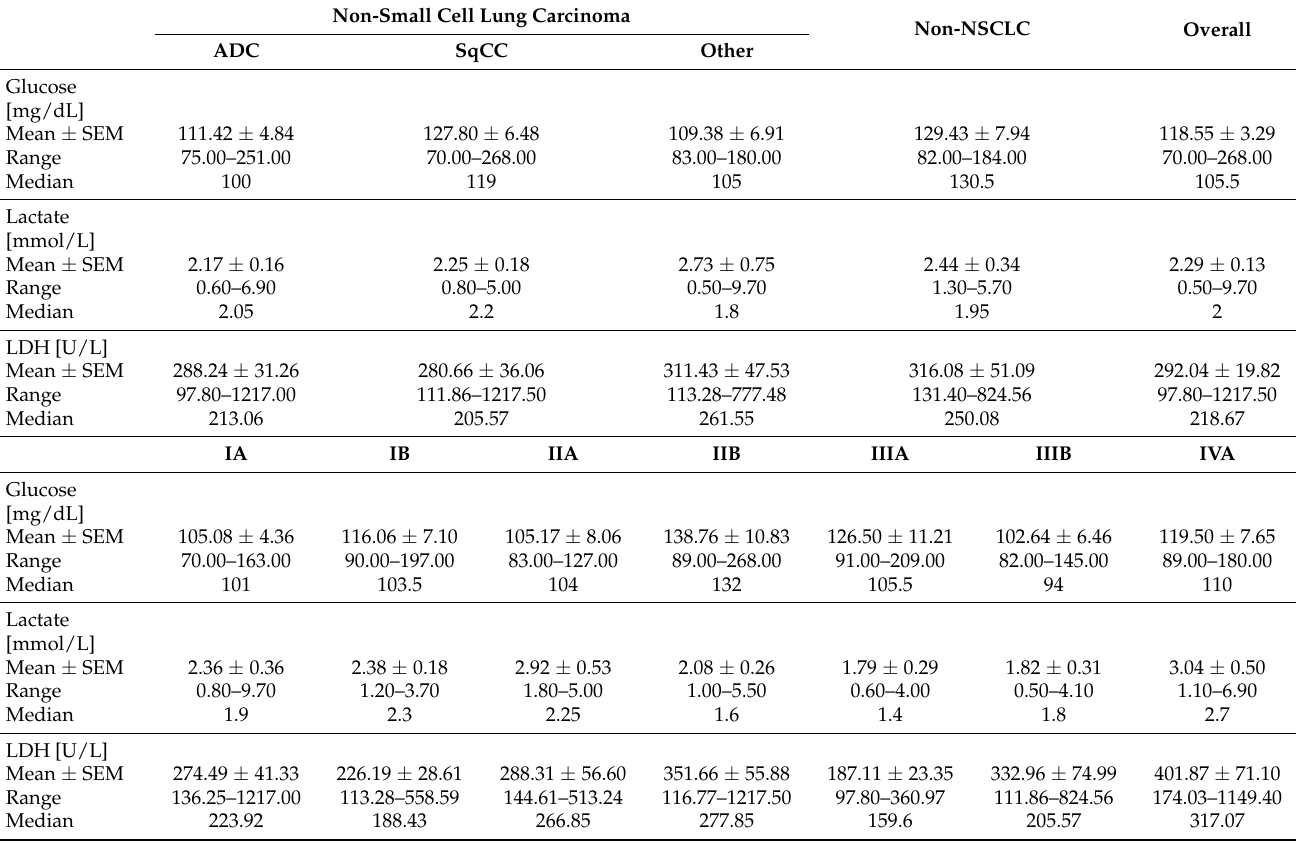
Non-NSCLC Overall